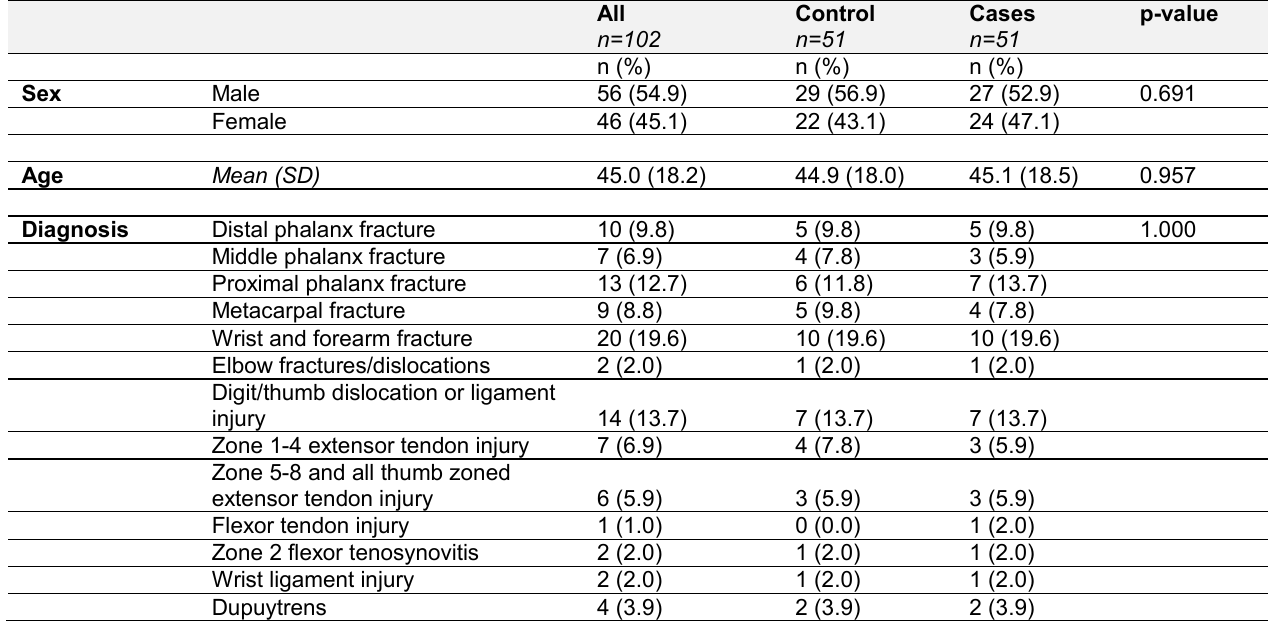
Baseline Demographic and Clinical Characteristics of